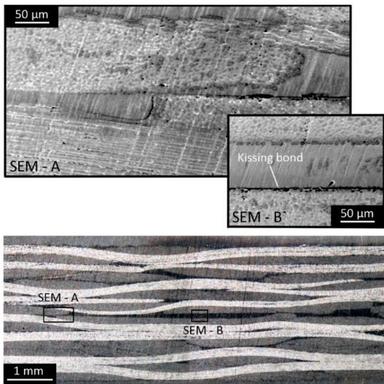
Cross-section of the 6 � 6 mm defect specimen, including SEM images from the edge (SEM – A) and middle (SEM – B) of the defect area.